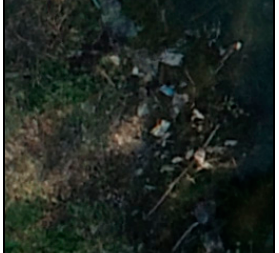
Figure 8. Fine-tuning the HMH model on TT is weak in some cases. ( a ) TT model result on TT. ( b ) HMH model results on TT with fine-tuning. Transfer learning confidence scores are lower. (Note: bar-like objects are galvanized stainless steel roof sheets).